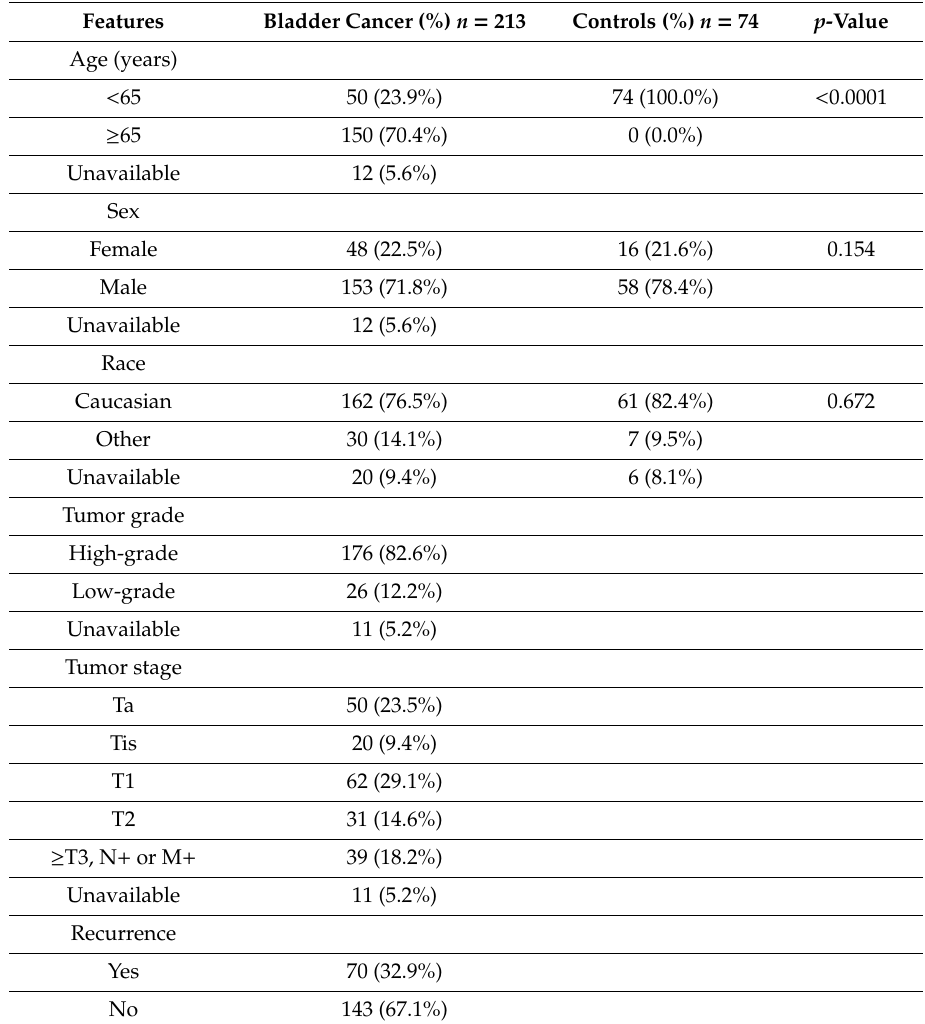
Table 1. Demographic, clinical, and pathologic characteristics of the 287 subjects comprising the study